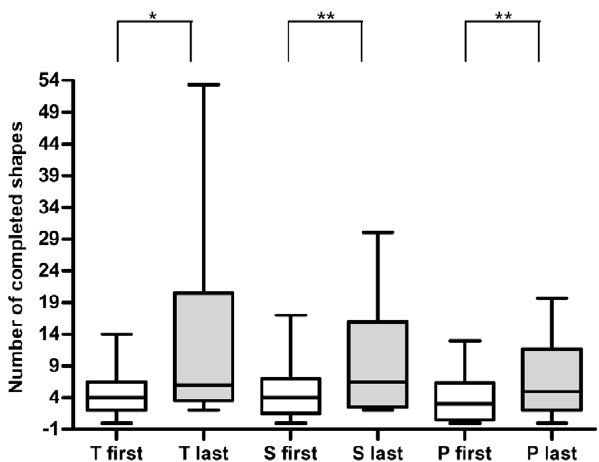
Figure 2. Behavioral results of task ML blindfold . Box-and-whisker plots show amount of completed shapes of the first and last sequence of each shape. T=Triangle; S=square; P=Pentagon. *=p , 0.05. **=p , 0.01.